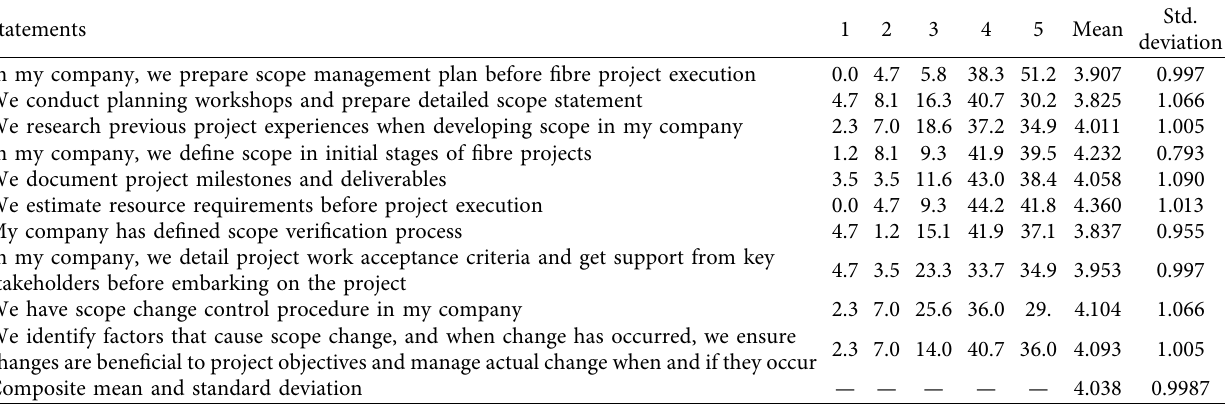
Table 5: Project scope Likert scale data.